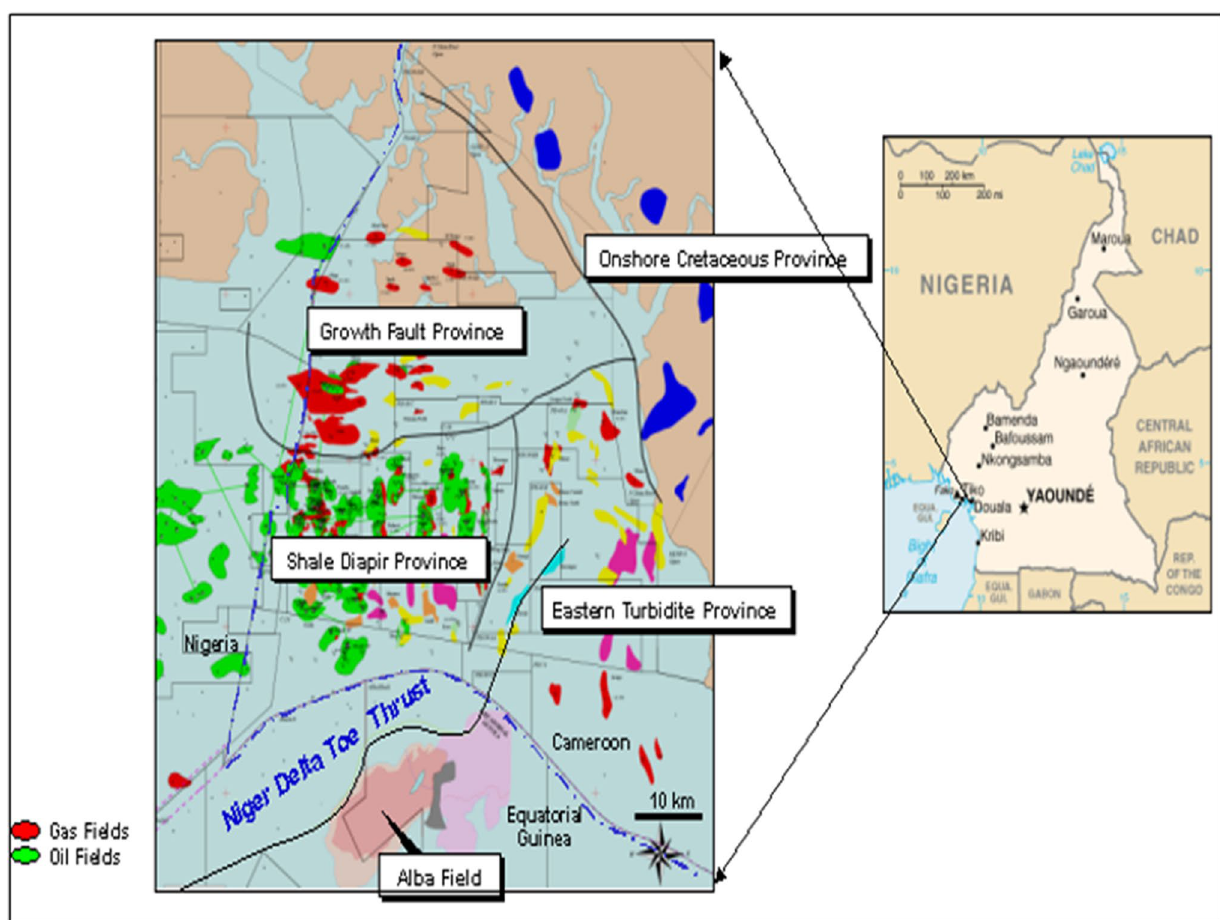
Fig. 2 Regional structural setting of the RDR Basin showing the four provinces (Kumar